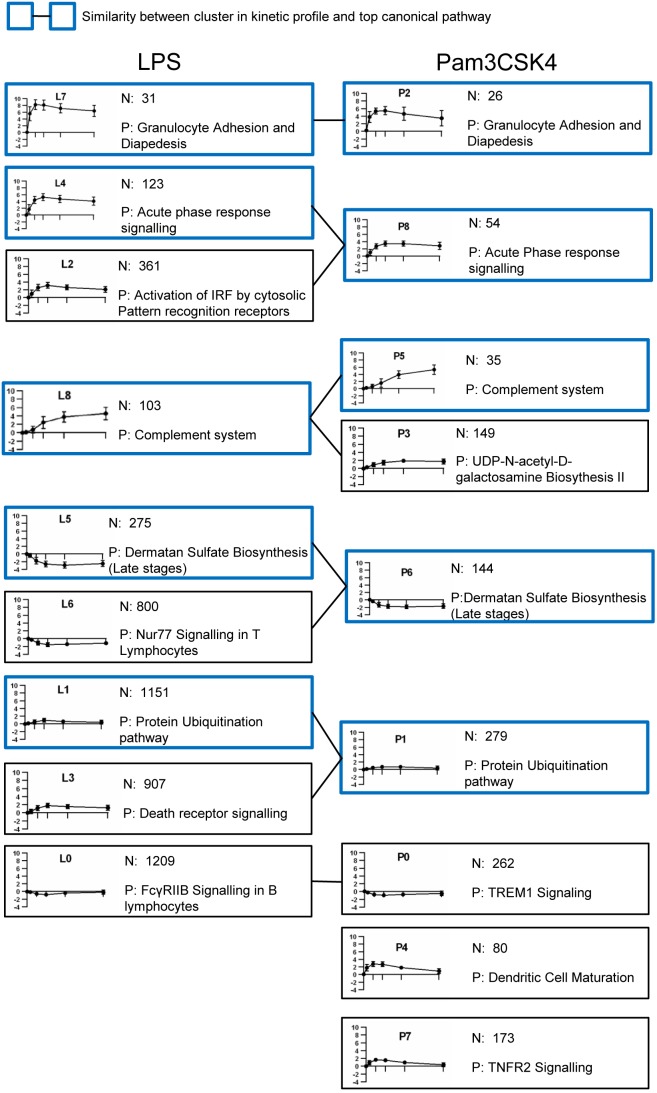

k-means clustering of the significant transcript lists reveals similar clusters.Mean normalised expression profile of individual clusters (y axis, ±SD, n = 4) at each time point (x axis; 0, 1, 3, 6, 12 and 24 hours) for each cluster. N: number of transcripts within cluster; P: most significant canonical pathway (IPA). Clusters are grouped by similarity in kinetic profile (Pearsons correlation, Table S2) and top canonical pathway.